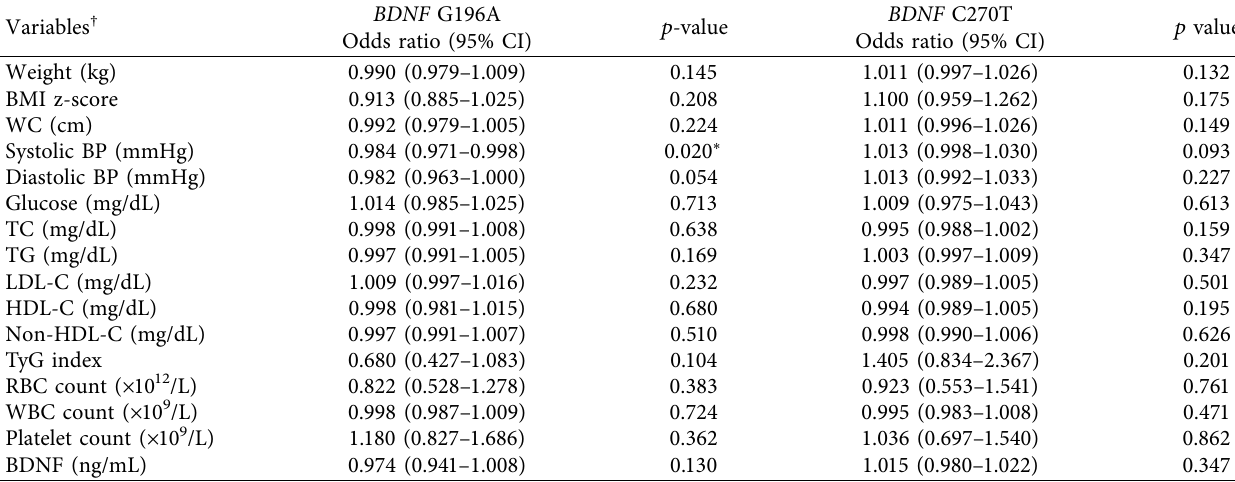
Table 3: Logistic regression analysis of anthropometric-cardiometabolic and hematological variables associated with the single nucleotide polymorphisms BDNF G196A and C270T ( N � 469).